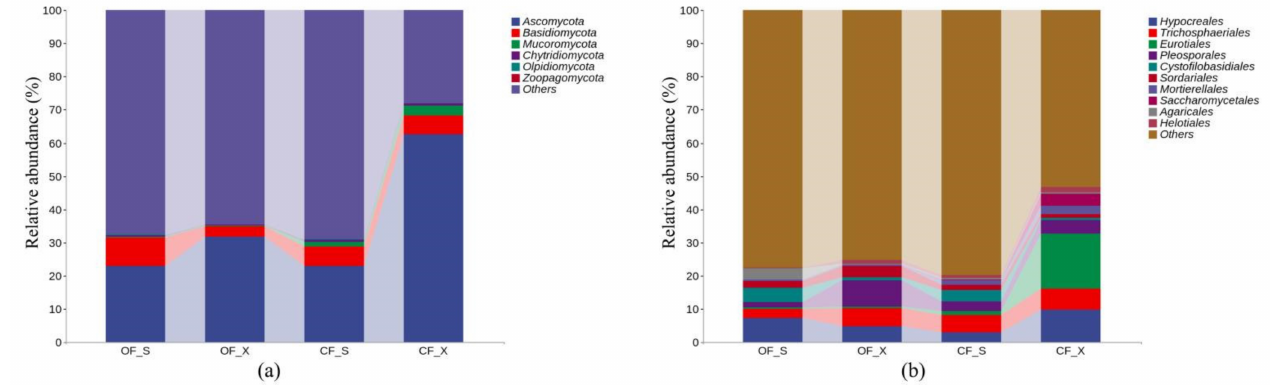
Figure 5. Relative abundance of fungi at ( a ) phylum level and ( b ) order level.